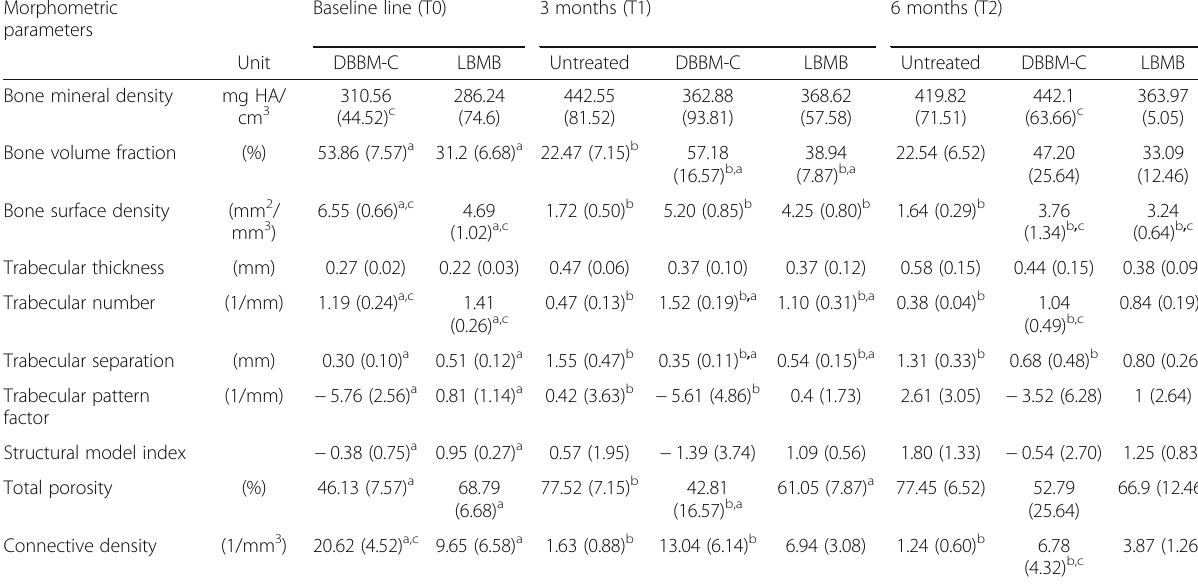
Table 1 Descriptive analysis of morphometric parameters for the untreated bone defects and deproteinized bovine bone mineral with collagen (DBBM-C) and lyophilized bovine medullary bone (LBMB) for different post-operative periods